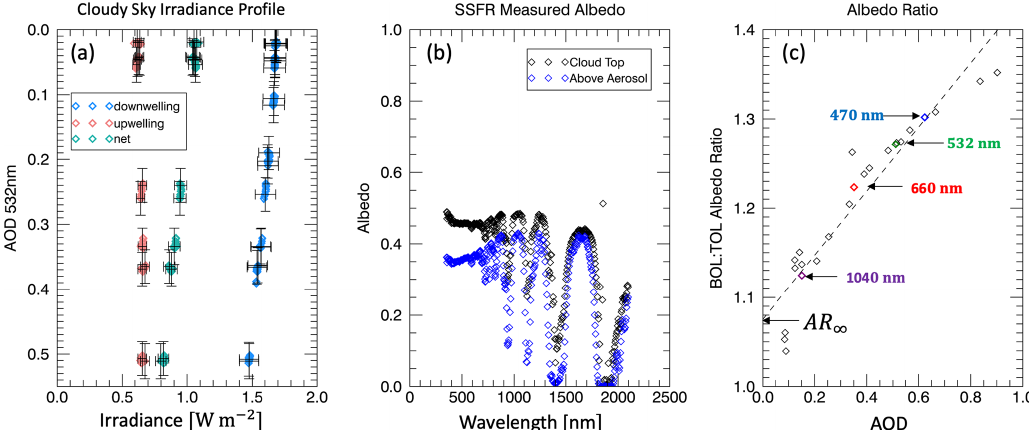
Figure 2. (a) Above cloudy sky upwelling, downwelling, and net irradiance profiles shown vs. the 532nm AOD measured by 4STAR with associated measurement error bars for one example case. The AOD refers to the air above the aircraft and generally decreases with increasing aircraft altitude, hence the inverted y axis. (b) SSFR-measured albedo spectrum at the bottom of the spiral (cloud top) and at the top of the spiral (above the aerosol layer). (c) The ratio between the BOL and TOL albedo spectra (taken from Fig. 2b) shown against the BOL AOD spectrum at the 4STAR wavelengths. The intercept of the fit line is criterion 3 (AR ∞ ); if the intercept deviates largely from 1.0, the case cannot be used for an aerosol retrieval. Select wavelengths are labeled to highlight the spectral importance of this